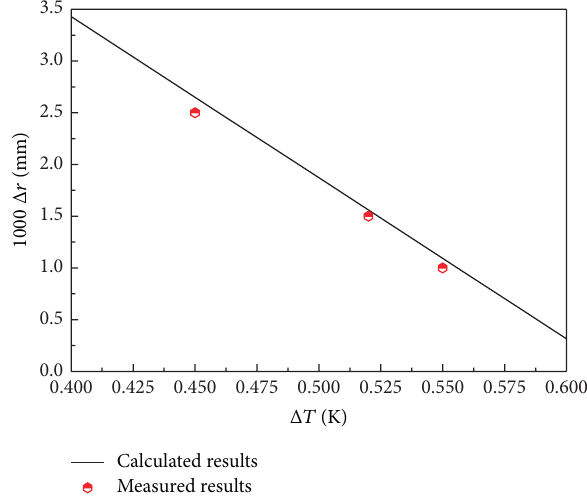
Figure 10: Comparing between the experimental results and the calculated